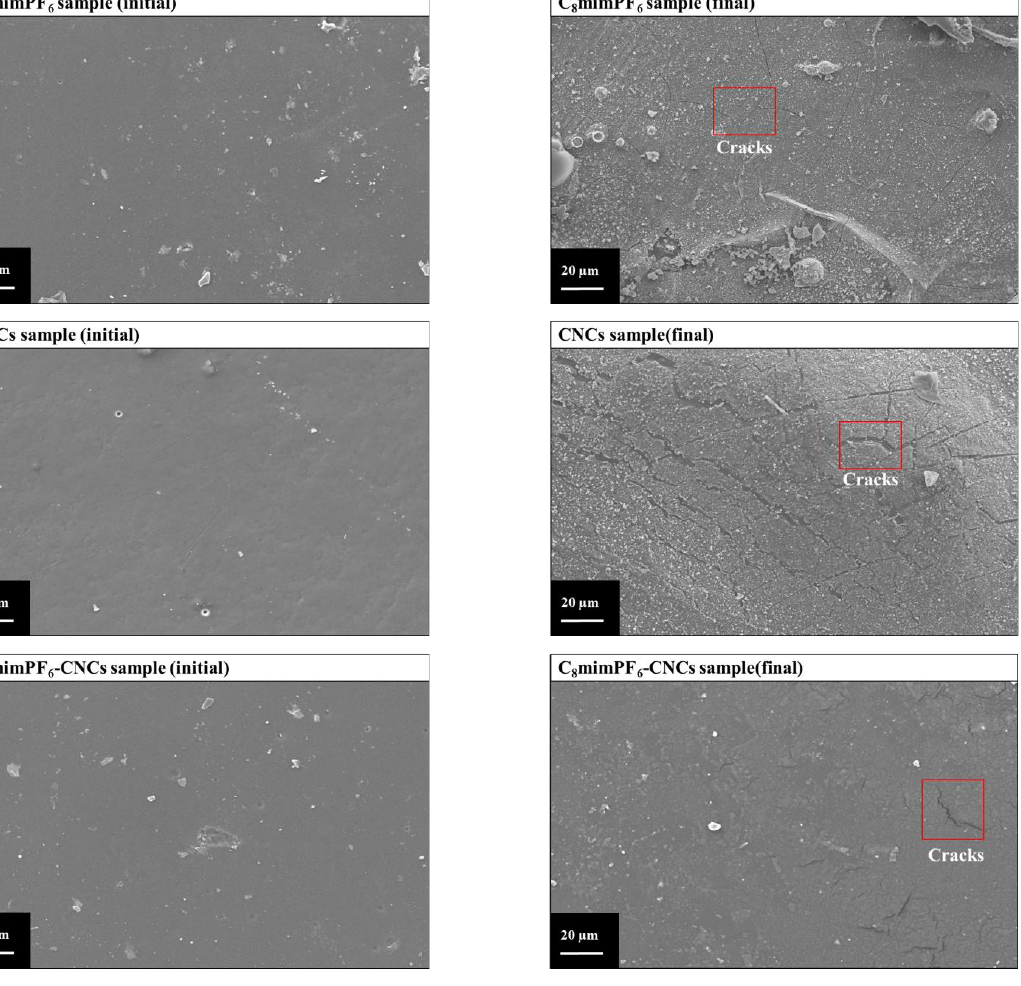
Figure 8. Surface morphology of coated and uncoated samples before and after 96 h of immersion in 3.5 wt% NaCl solution (500 times